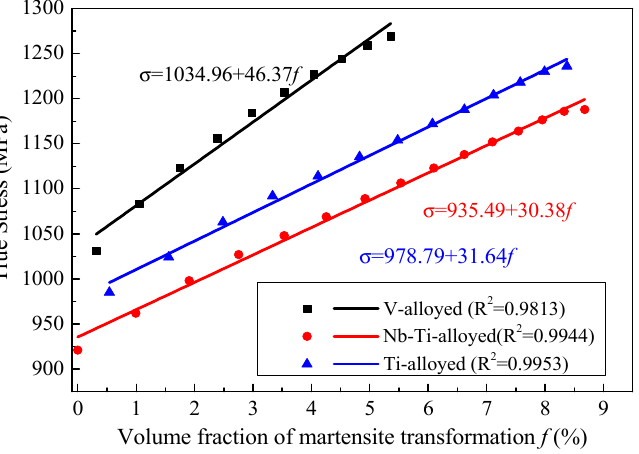
Figure 10. Relationship between true stress and volume fraction of martensite transformation.